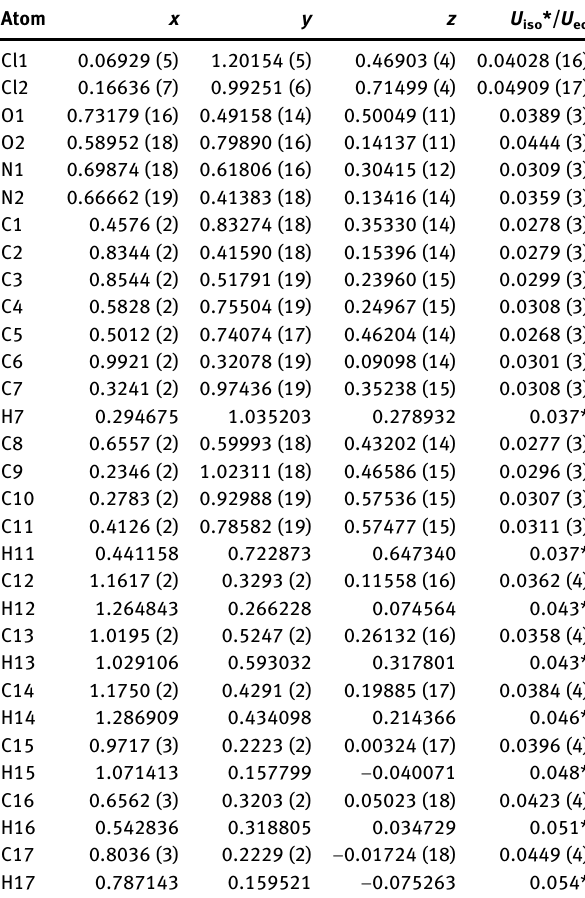
Table  : Fractional atomic coordinates and isotropic or equivalent isotropic displacement parameters (Å 